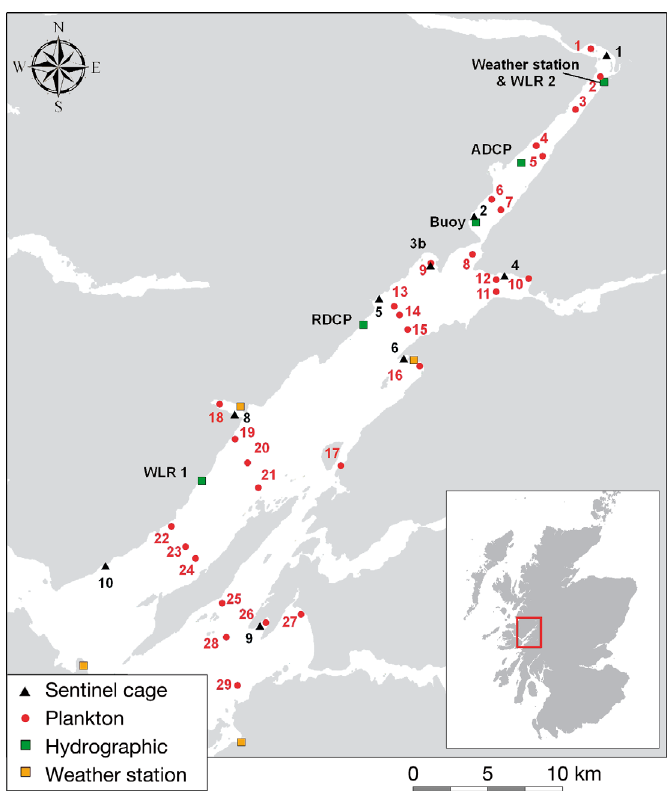
Fig. 3. Loch Linnhe on the west coast of Scotland, showing multi- disciplinary sampling stations for biological and physical model vali- dations (WLR: water level recorder, ADCP: acoustic doppler current profiler, RDCP: recording doppler current